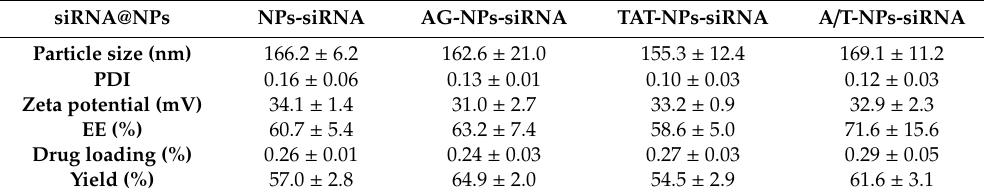
Table 3. Characteristics of siRNA@NPs ( n = 3).